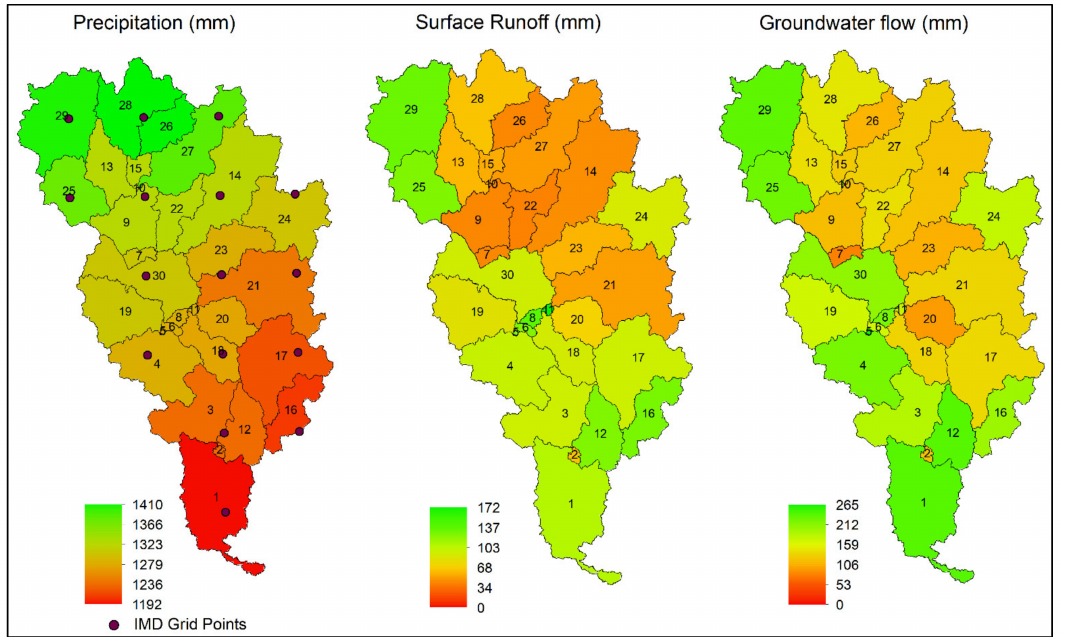
Figure 11. Spatial distribution of average annual precipitation, surface runoff and groundwater flow over the Vamsadhara river basin for the period of 24 years